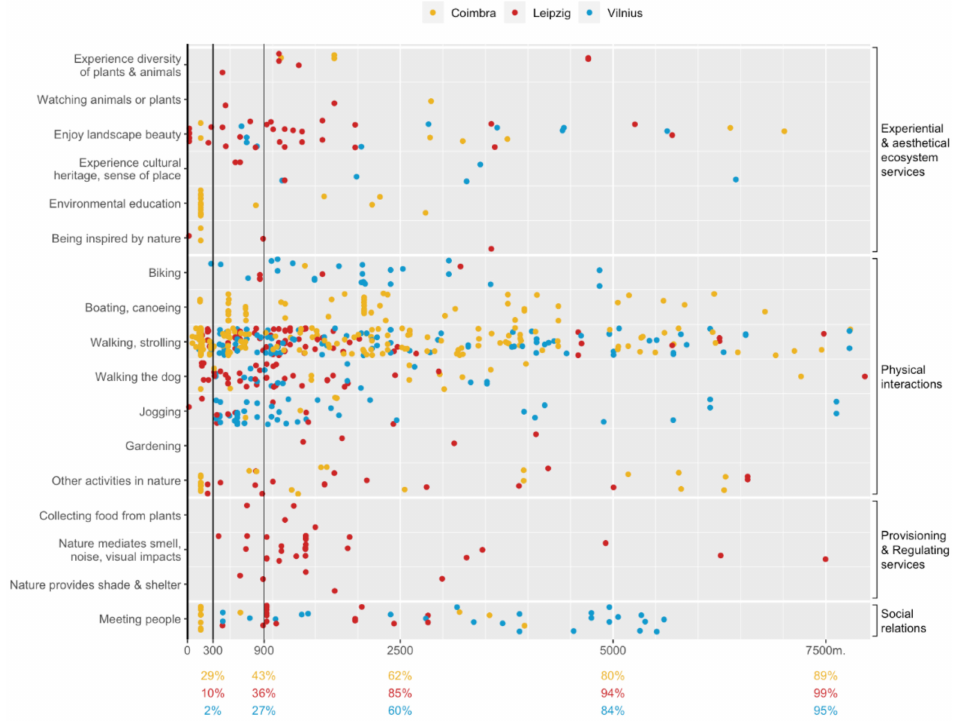
Figure 3. Distribution of answers by ecosystem services and by distance to parks. Most citizens in all three cities used individual transportation to reach the parks, and only a minority used public transport (ranging from 6% in Coimbra to 10% in Leipzig and Vilnius). Walking was the dominant way of accessing the parks in the three cities, but with a significant difference between Leipzig—almost 70% of users arrived by foot—and the other two cities—less than 50% arrived by foot. Chi-square test reveals significant differences in means of transport specified by respondents ( p < 0.001). The number of people arriving by car was considerably higher in Coimbra, while the number of people arriving by foot or bike was much lower compared to the other cities (see Pearson’s residuals in Supplementary Materials Table S2). Mostly cars were used to cover larger distances, followed by public transport, being the second most common means of transportation, although only 7% of the users in Leipzig arrived by car, compared to 28% in Vilnius and 46% in Coimbra. A very prominent difference between cities was bikers, mostly absent in Coimbra (0.3%), but representing considerable proportions of users in Leipzig (14%) and Vilnius